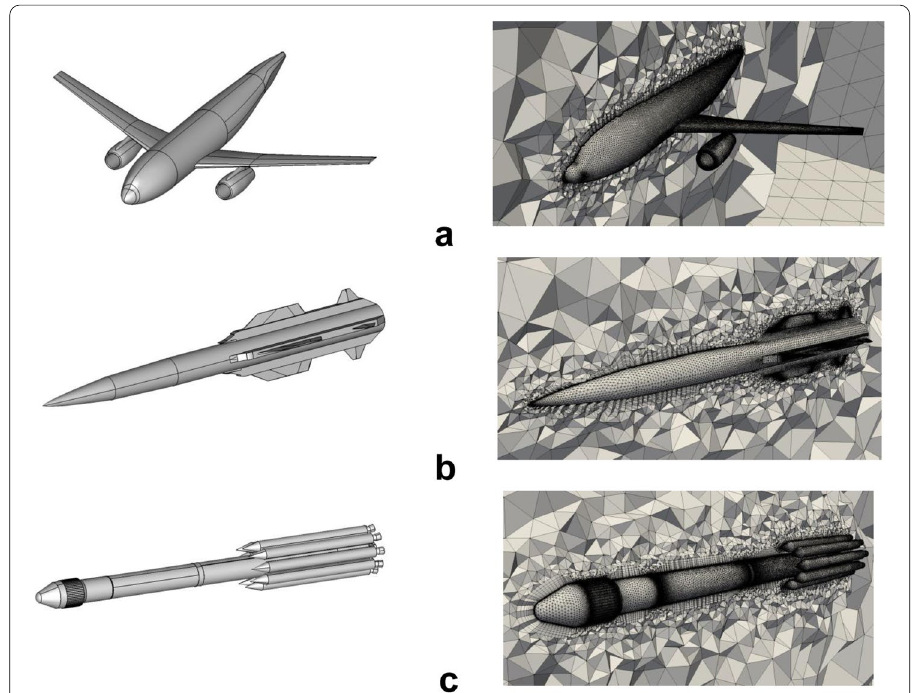
Fig. 10 Three groups of inputs selected for numerical tests. Left is the CAD model, and right is the coarse volume mesh filling in the exterior flow domain. a The DLR F6 aircraft model, b The missile model, c The rocket model